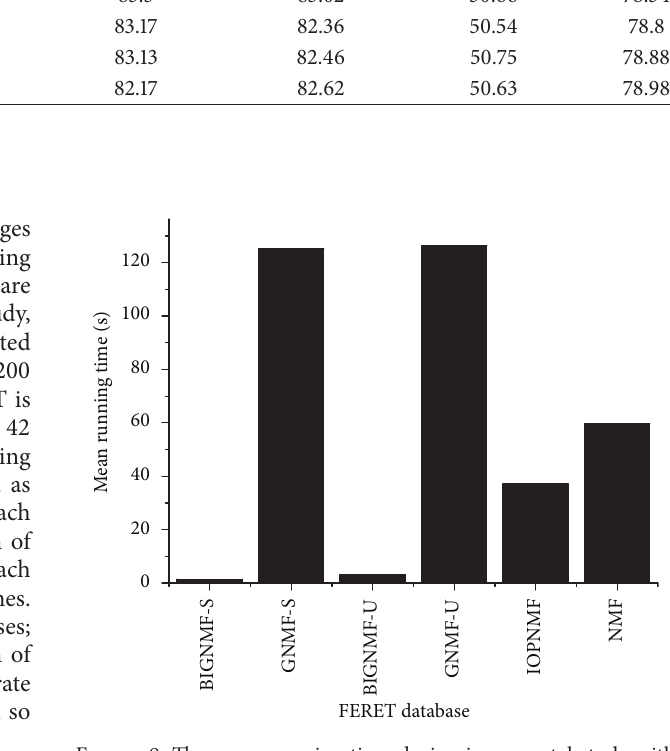
Figure 9: The mean running time during incremental study with images belonging to different classes for the FERET